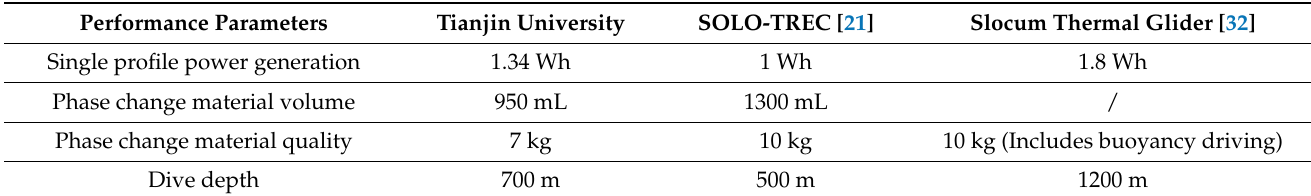
Table 2. The performance parameters of the PCM-based electrical energy storage